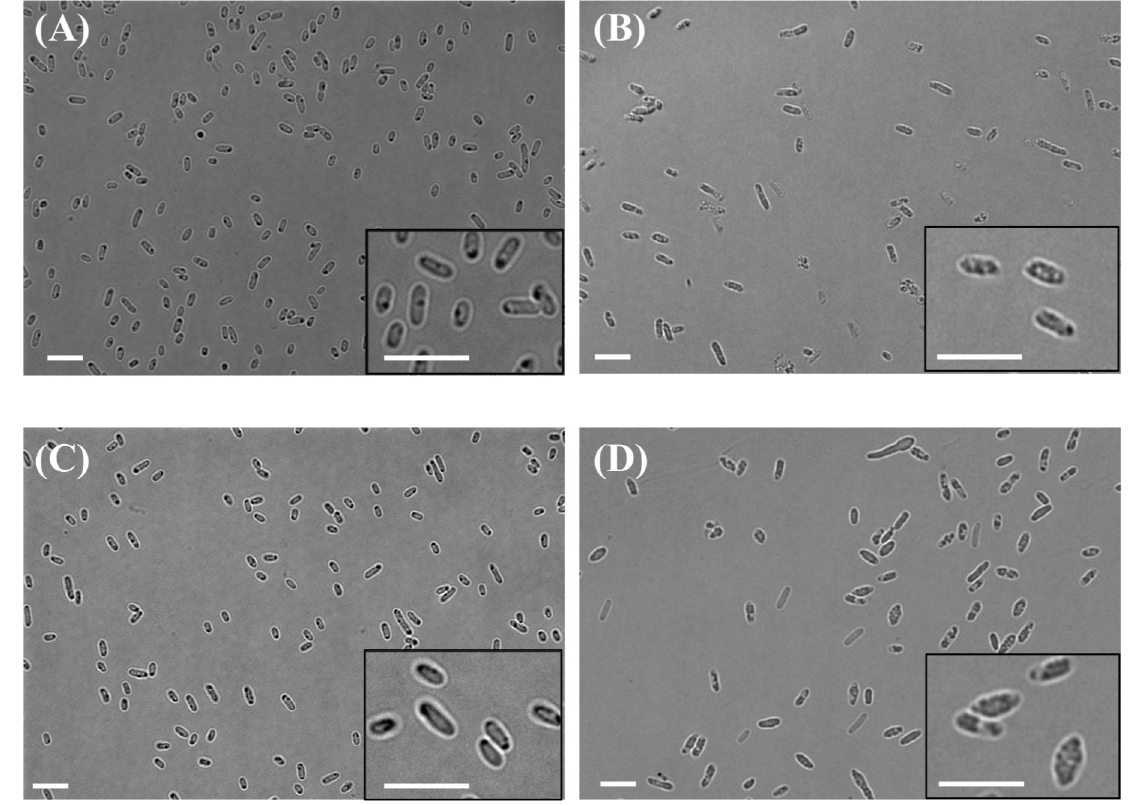
Fig 3. Effect on the cell volume exerted by polymer production in the wild-type and mtgA -deleted E . coli . The cells were grown on LB medium containing 2% glucose. E . coli BW25113 (wild-type) harboring pTV118N (empty vector) (A) and pTV118N pctphaC1 Ps (ST/QK) AB (B). E . coli JW3725 ( Δ mtgA ) harboring pTV118N (C) and pTV118N pctphaC1 Ps (ST/QK) AB (D). The cells harboring pTV118N did not produce detectable amount of polymer. Scale bars = 5 μ m.